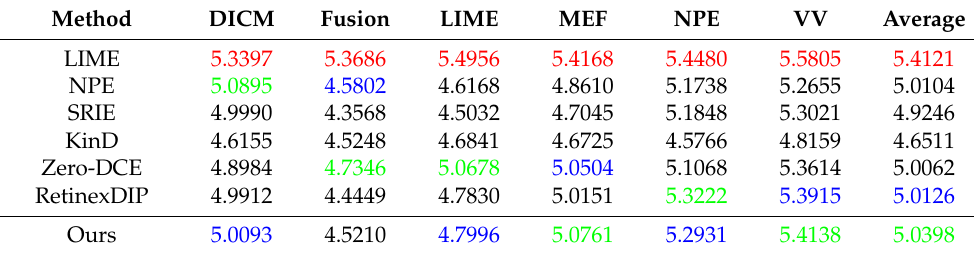
Table 2. Comparison of average NIQMC on six datasets. (The red, green, and blue scores represent the top three in the corresponding dataset, respectively).